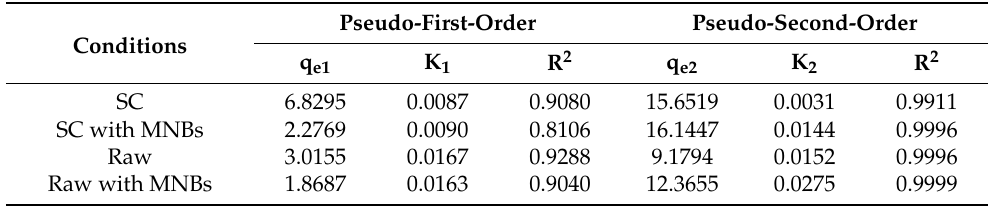
Figure 5. Pseudo-second-order for dye adsorption onto raw coal and SC ( a ). Fitting curves for internal diffusion of SC adsorbing CR dye ( b ). Table 1. Kinetic parameters for CR dye uptake onto raw coal, raw coal with MNBs, SC and SC with MNBs.